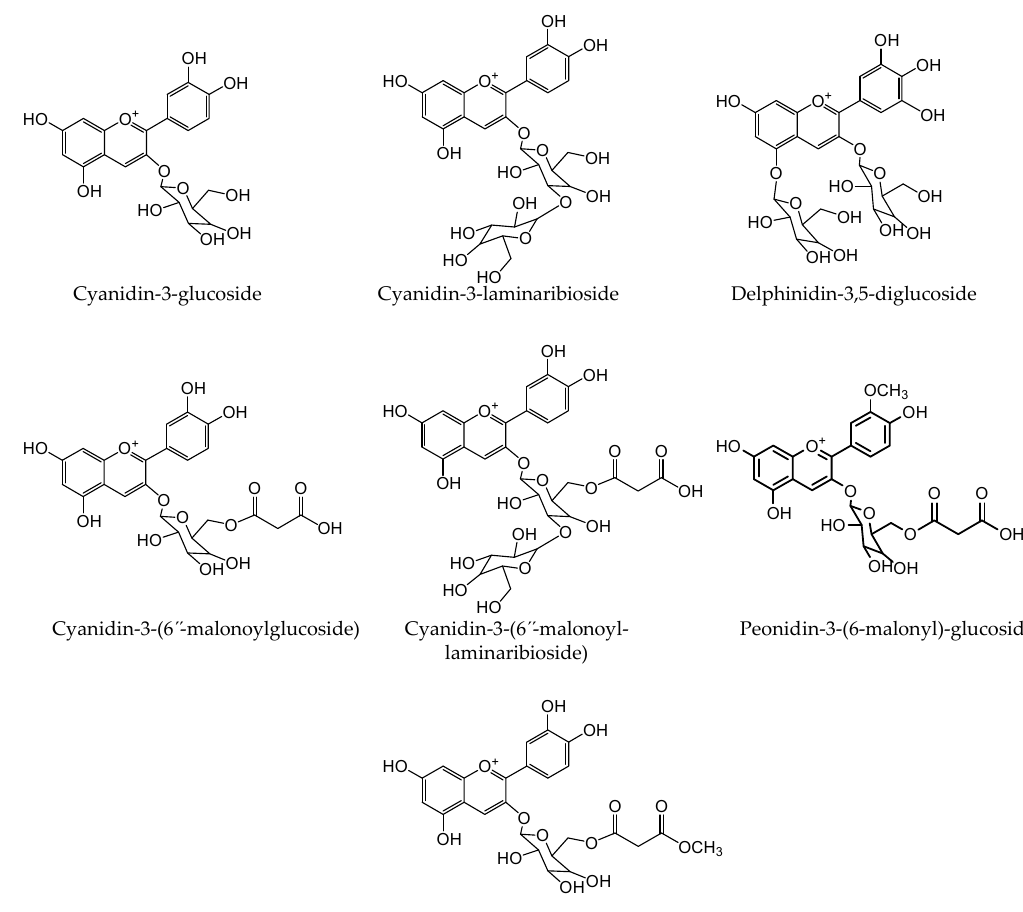
Figure 8. Structure of identified anthocyanins from red onions.